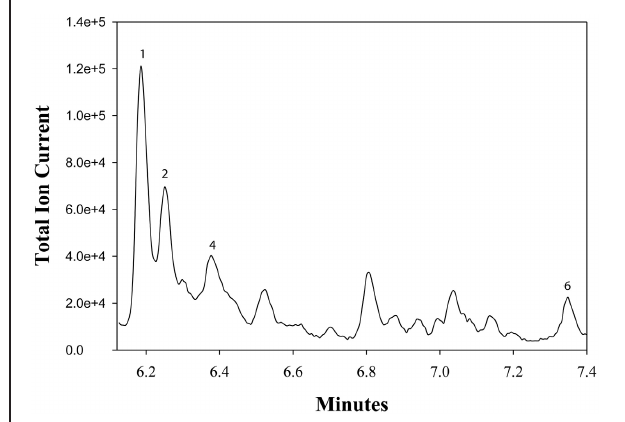
FIGURE 5 | A chromatogram of norcarane hydroxylation products, as metabolized by strain EPR21. Norcarane was introduced in the vapor phase, and the cells were then incubated for 10h. Products are identified in Figure 3